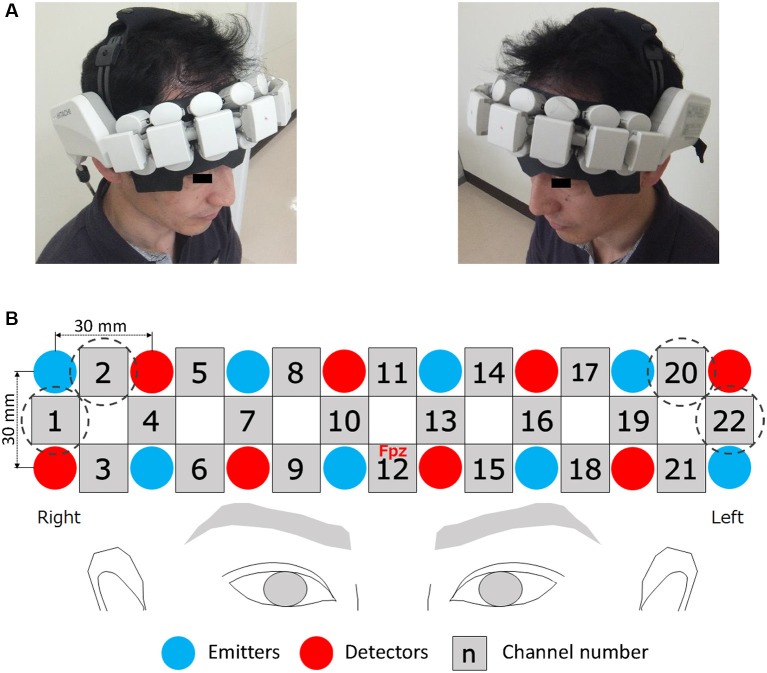
Wearable NIRS device. The attached probe unit (a wearable package as a headset) can fully cover the forehead (A). In the probe unit, emitters and detectors are alternately arranged in two rows at an inter-probe distance of 30 mm (B). The center channel was placed on the Fpz point. Channels surrounded by dotted circles were excluded from analysis. Written informed consent was obtained from this individual (A) for publication of this image.